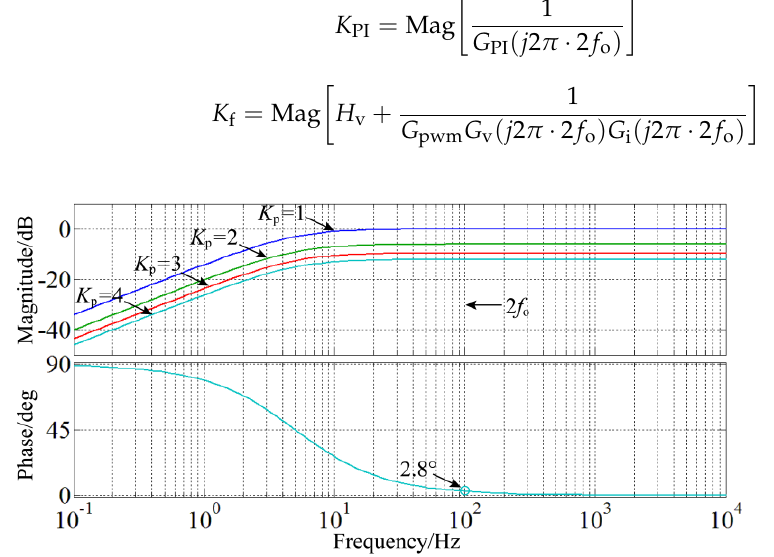
Figure 4. Bode diagram of 1/ G PI ( s ) with different K p when f L = 5 Hz.